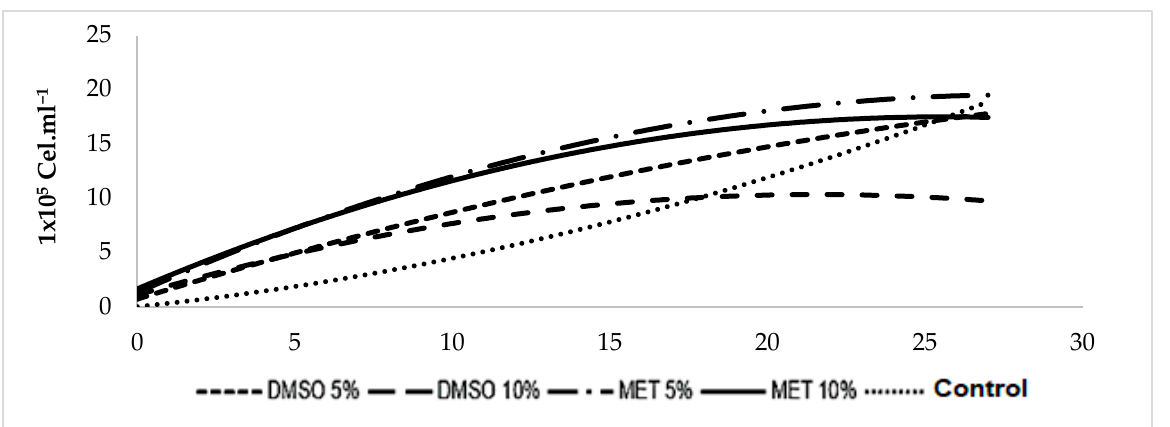
Figure 5. Adjustment models (trend lines) for post-thaw population growth curves of Scenedesmus sp. DMSO 5%. y = − 976.4x 2 + 89,625x + 71,721, r 2 = 0.9582; DMSO 10%. y = − 1988.1x 2 + 85,788x +